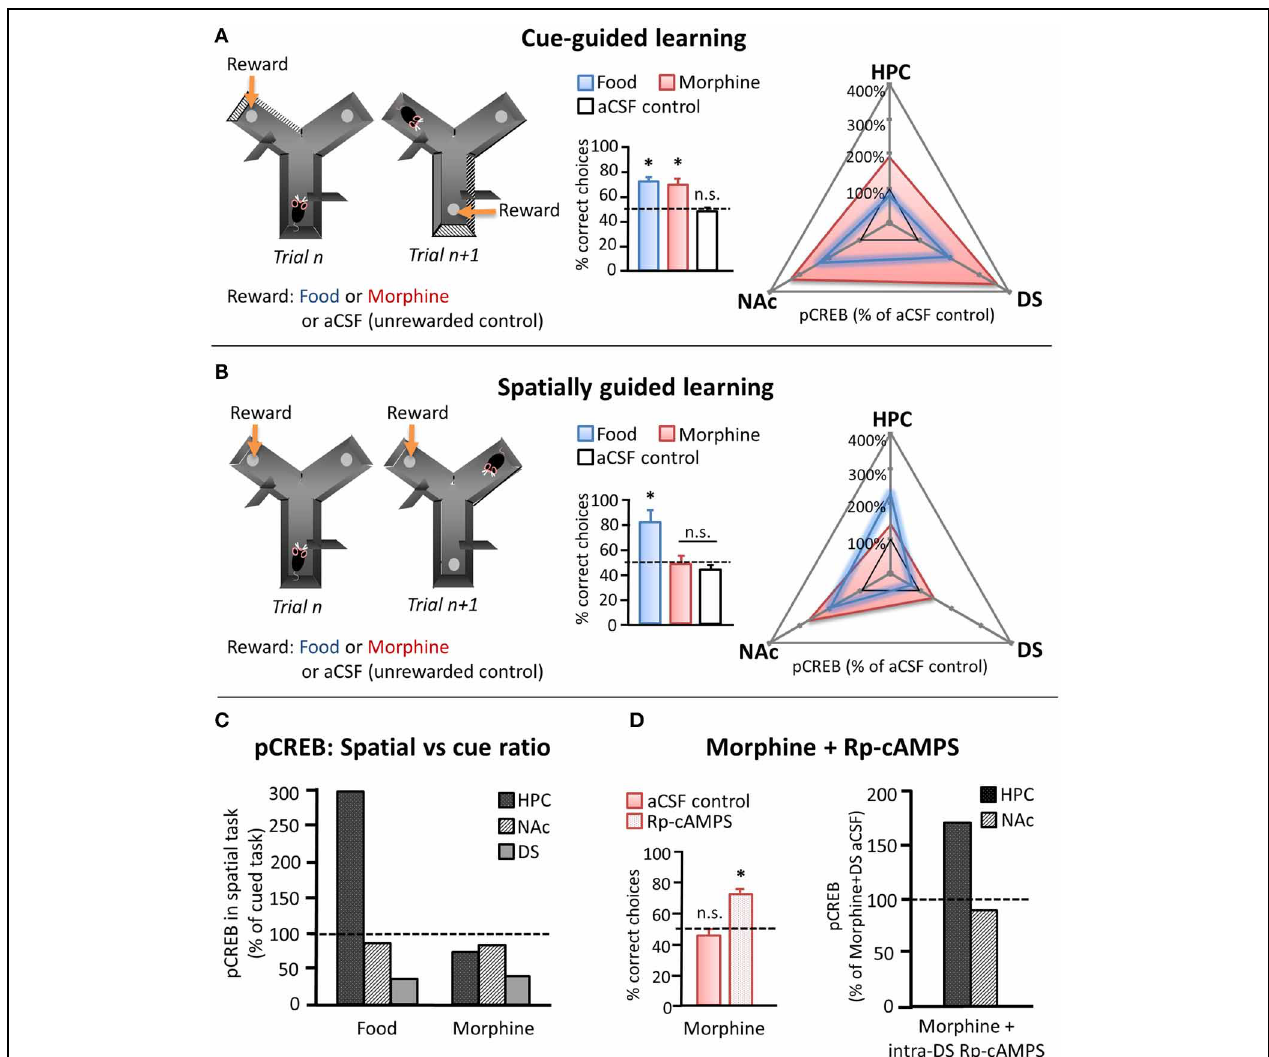
FIGURE 2 | Effects of natural and pharmacological reinforcers on the acquisition of cue- and spatially-guided learning strategies. (A, B) Left panels depict schematics of a cue-guided (A) and a spatially guided (B) version of a Y-maze decision making task. Correct responses were guided either by intramaze visual cues or by spatial location, respectively, and were reinforced in separate groups of mice by either food reward or intra-VTA morphine infusions. Control mice received intra-VTA aCSF infusions and no food reward at the “correct” location. Middle panels depict choice performance on the 10th day of training on the respective task (chance performance = 50%, marked with dashed line). Right panels depict pCREB levels measured in NAc, dorsal striatum (DS), and the hippocampus (HPC) of food- and morphine-reinforced mice after 10 days of